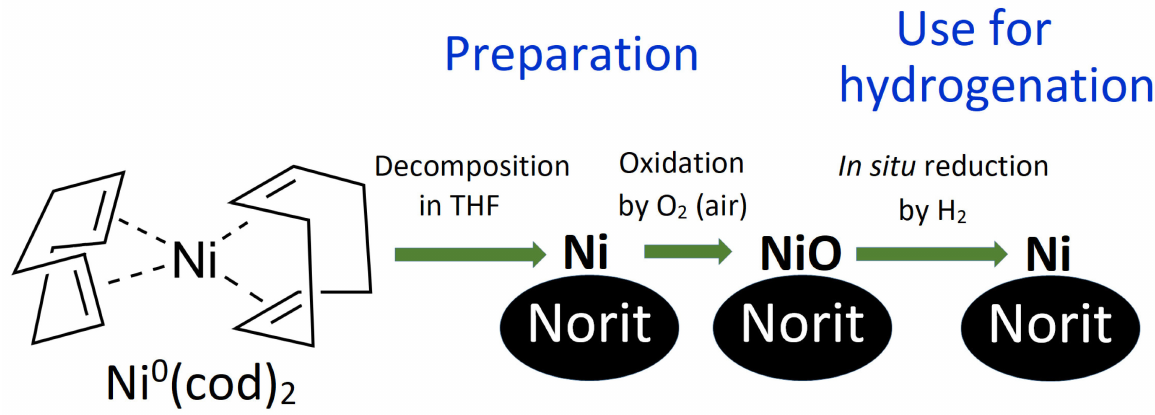
Figure 1. Scheme of the preparation and use of Ni/C-X composites and formula of the Ni(cod) 2 complex, used as a precursor for Ni